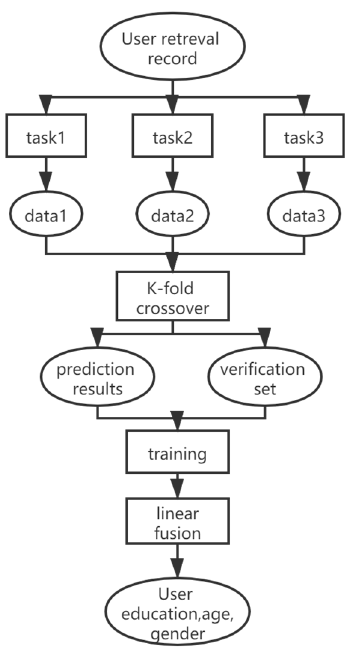
Figure 2. Multi-model execution Figure 2. M ulti-model execution process.